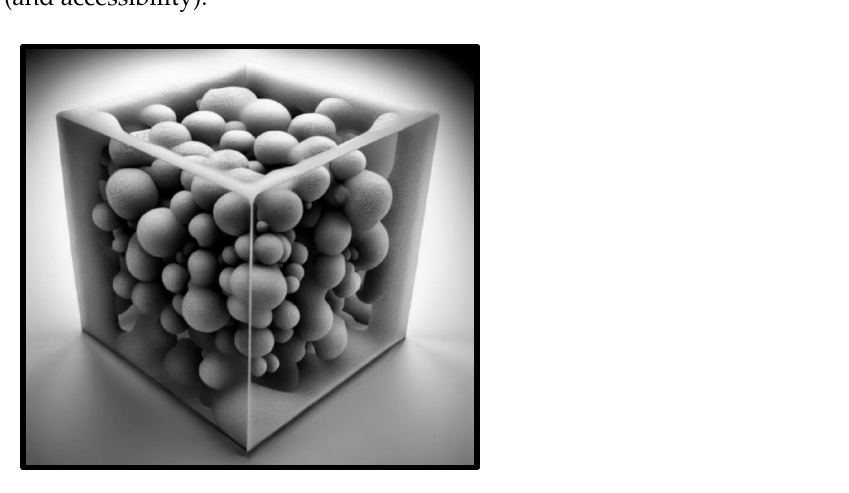
Figure 8. Three-dimensional micro-CT reconstruction model of a porous catalyst sample showing pore connectivity .